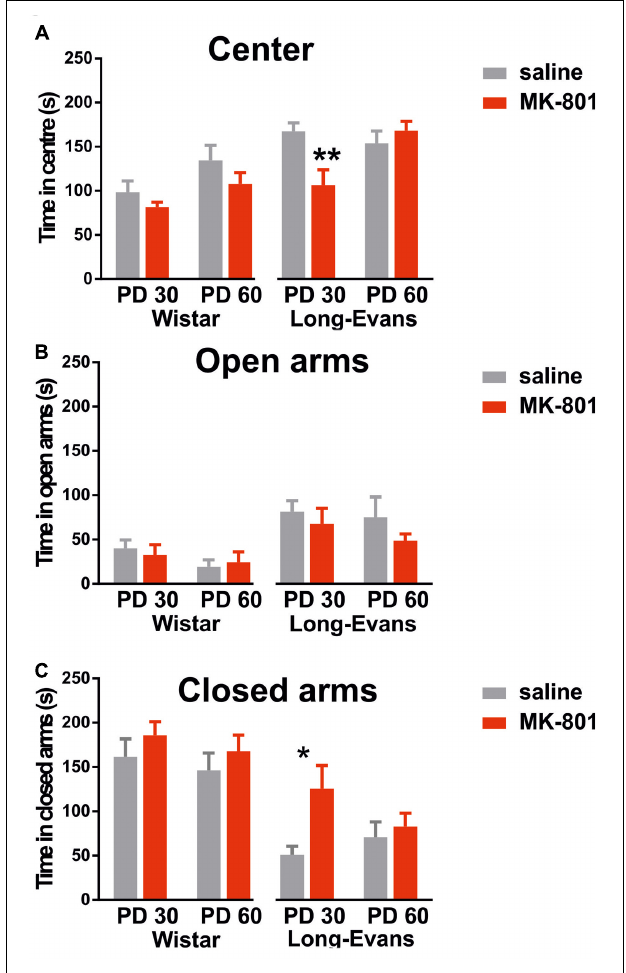
FIGURE 2 | Performance in the elevated plus maze evaluated by total time spent in the central part (A) , open arms (B) , and closed arms (C) . Comparing MK-801 and saline-treated rats in each cohort yielded significant differences only for PD 30 Long-Evans rats in entering the center, and for PD 30 Long-Evans rats in entering the closed arms. Group means ± SEM ( ∗ P < 0.05, ∗∗ P <